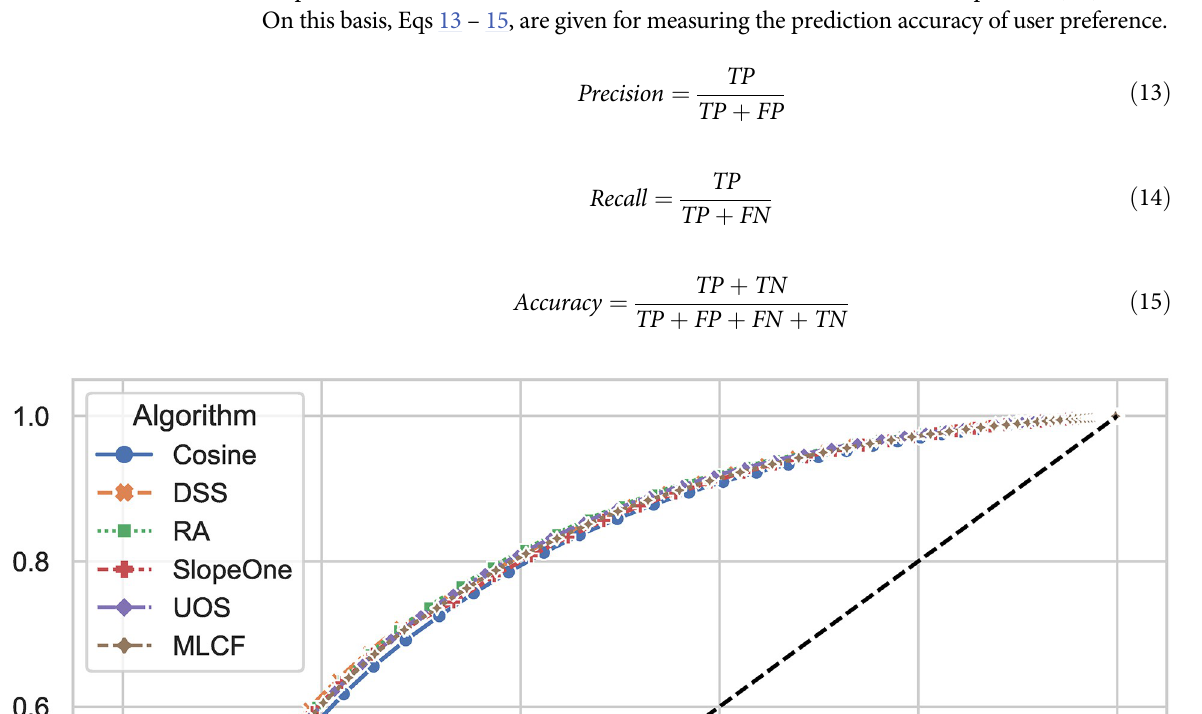
PLOS ONE | https://doi.org/10.1371/journal.pone.0271891 July 28,